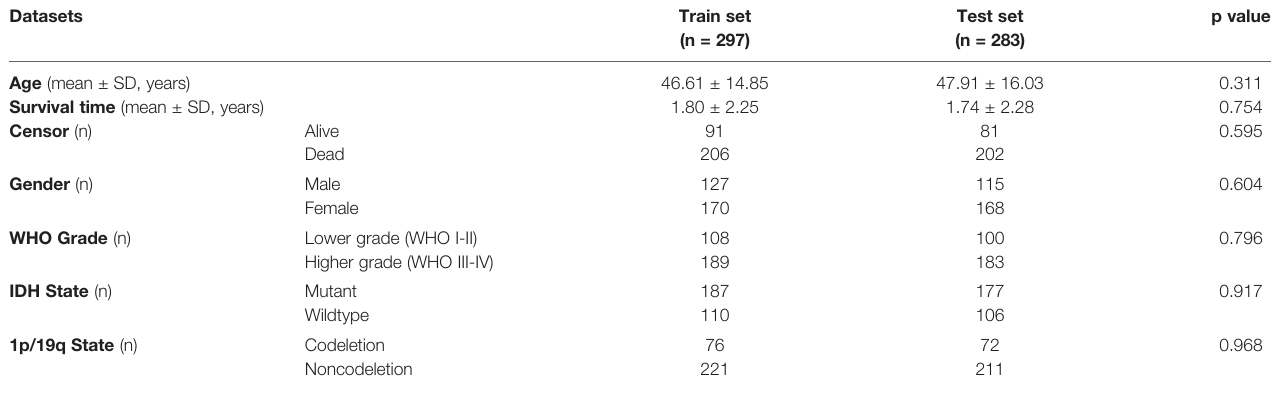
TABLE 1 | The clinicopathological features of glioma patients in the training set and test set. Datasets Train set Test